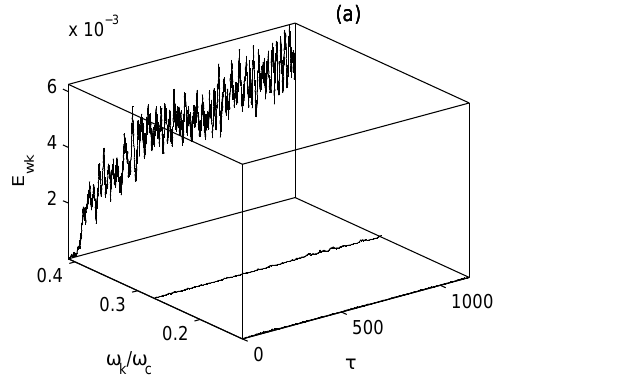
+ ω ; the cou- k 2 1 ω k /ω c ): the amplitudes /ω c = 0 . 133 , 1